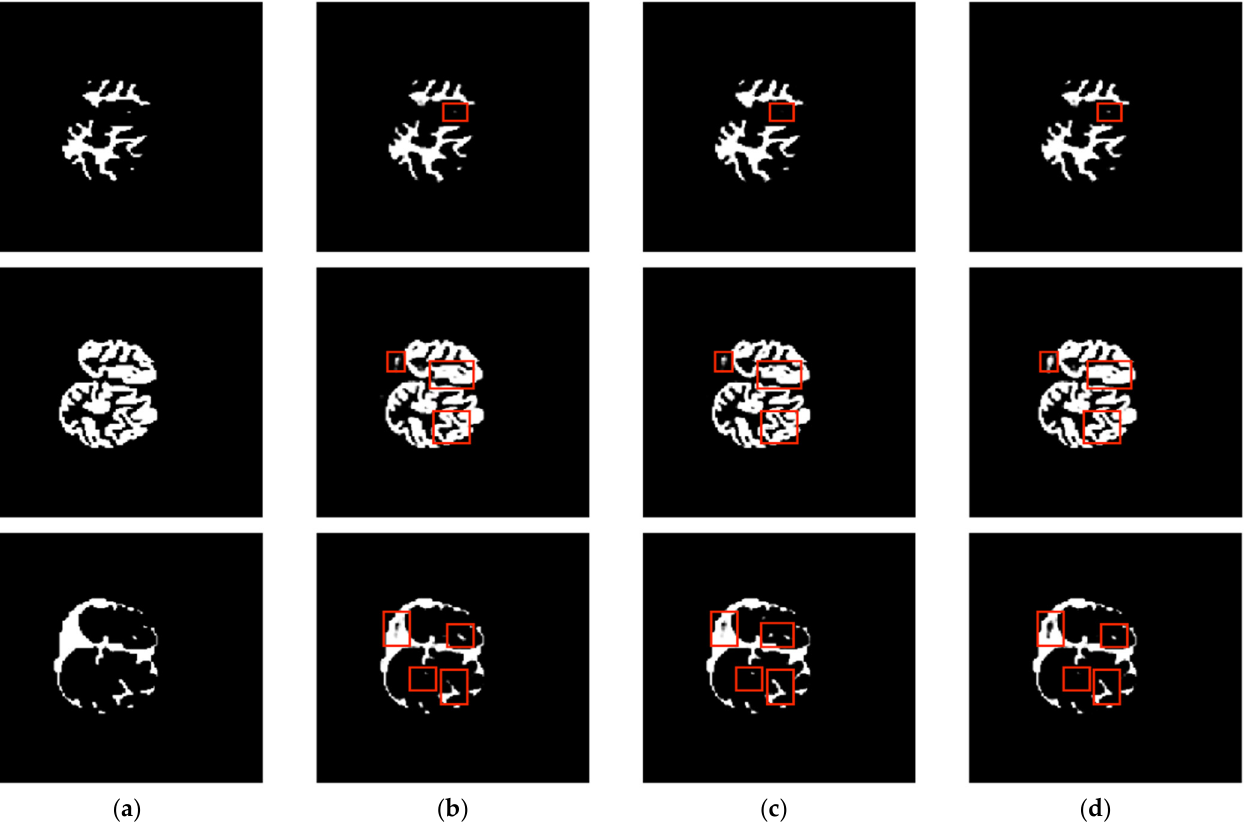
Figure 8. Architecture Illustration of segmentation results for coronal plane for existing methods and SIP-UNet for WM, GM, and CSF (top to bottom): ( a ) ground truth (binary map), segmented binary maps generated by ( b ) single-slice input UNet, ( c ) multi-slice input UNet, and ( d ) proposed SIP-UNet.